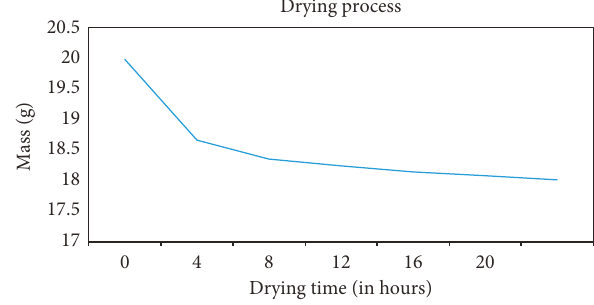
Figure 9: Specimen drying